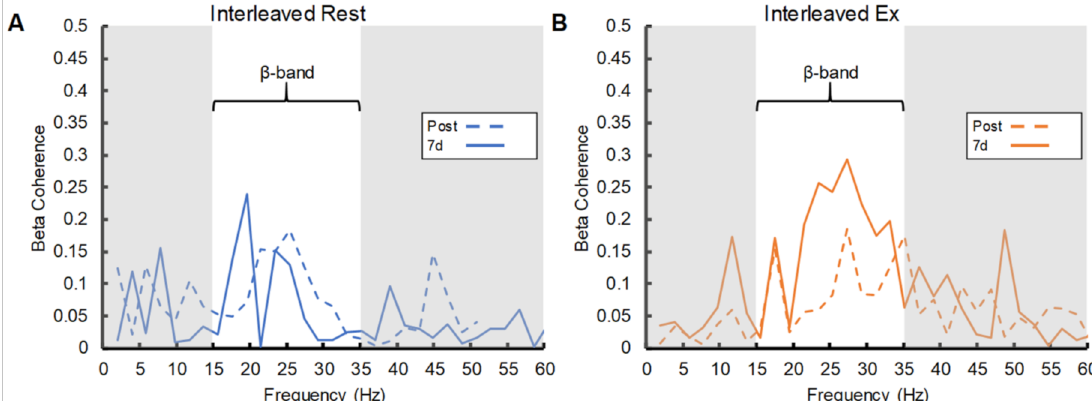
Figure 4. Intermuscular coherence data from representative participants and time points. Panel ( A ) shows data obtained from an individual in the interleaved practice and rest group. Panel ( B ) depicts data obtained from an individual in the interleaved practice and exercise group.